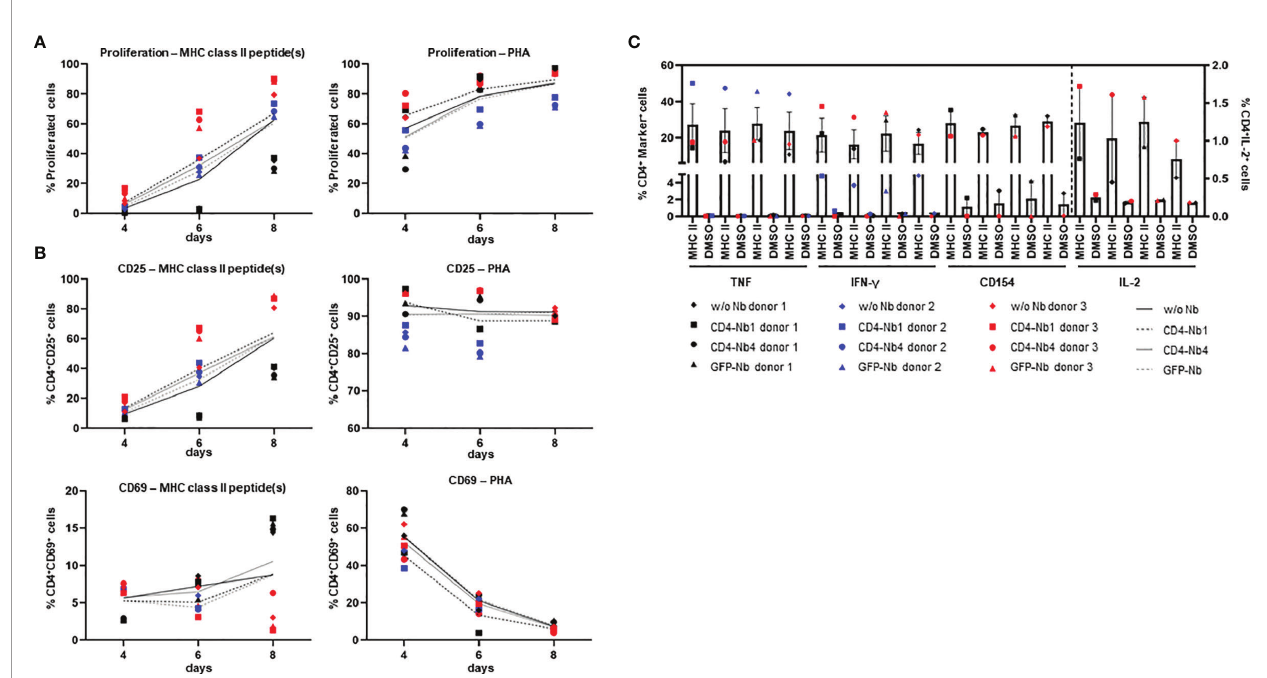
FIGURE 4 | Impact of CD4-nanobodies (Nbs) on activation, proliferation, and cytokine release of T cells. Cells were stained with carboxy fl uorescein succinimidyl ester (CFSE), treated with 5 µM Nbs or without for 1 h (one replicate each), washed, stimulated with 5 µg/ml MHCII peptides, 10 µg/ml PHA or not stimulated, and cultured for 12 days. (A) Cells were analyzed by fl ow cytometry for proliferation (CFSE-low/negative fraction) and activation (CD25 and CD69) on days 4, 6, and 8. Proliferation of CD4 + cells after stimulation with MHCII peptide(s) (left) or PHA (right). (B) Activation markers on CD4 + cells. Top: CD25 expression after stimulation with MHCII peptide(s) (left) or PHA (right); Bottom: CD69 expression after stimulation with MHCII peptide(s) (left) or PHA (right). Mean percentages of all three donors are shown as plain or dotted lines. (C) Cytokine and activation marker expression of CD4 + cells — TNF, IFN- g , CD154 (left y-axis), or IL-2 (right y-axis). Cells were restimulated on day 12 with MHCII peptide(s) or dimethyl sulfoxide (DMSO) (background) for 14 h in the presence of Golgi Stop and brefeldin A and analyzed by fl ow cytometry. Error bars display SEM. Gating strategy is shown in Supplementary Figure 6 ; all percentages are given within CD4 + T